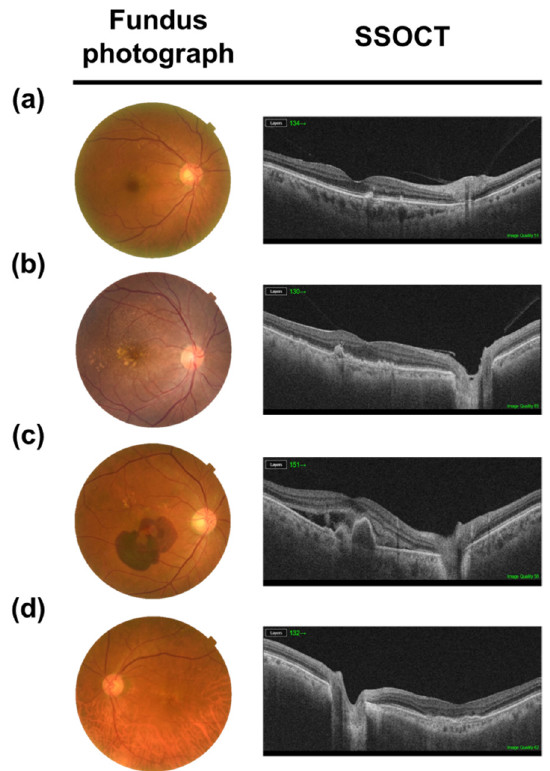
Figure 1. Multimodal image of age-related macular degeneration (AMD). Color fundus photograph and swept source optical coherence tomography (SS-OCT) images show the feature of early, intermediated AMD, neovascular AMD and geographic atrophy ( a , b ). Non-neovascular AMD (dry AMD): small and intermediate soft drusen. ( c ) Neovacular AMD (wet AMD): submacular hemorrhage, subretinal fluid and pigment epithelial detachement. ( d ) Geographic atrophy: retinal pigment epithelial pigment and photoreceptor atrophy at fovea.